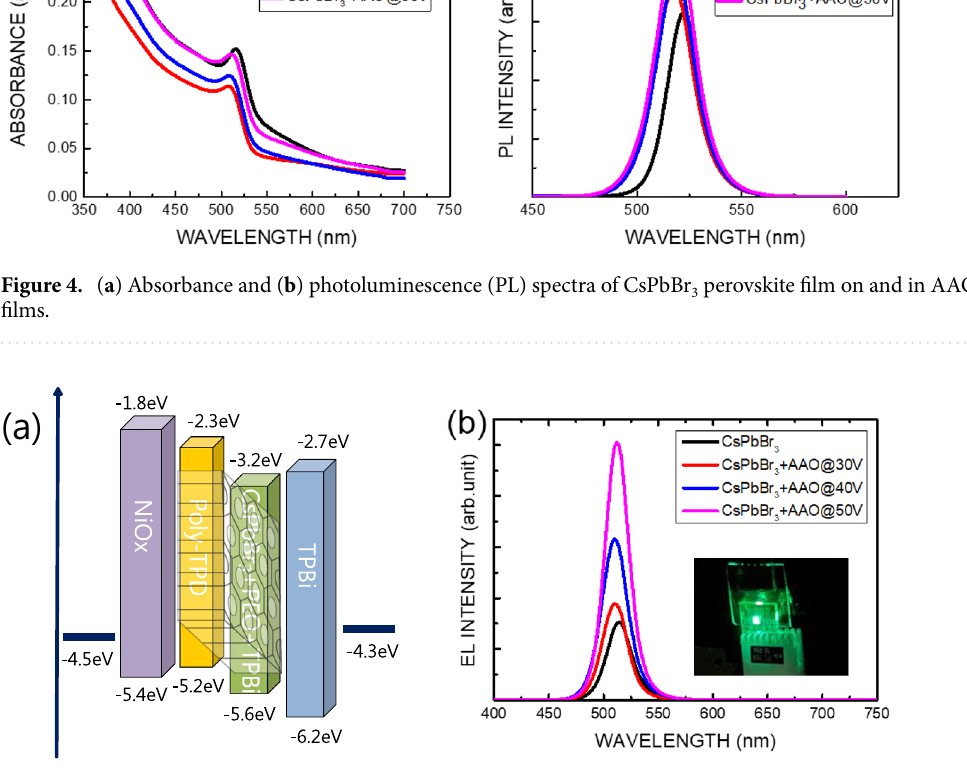
Figure 5. ( a ) Diagram of the electron level of a CsPbBr 3 PeLED with AAO. ( b ) Electroluminescence (EL) spectra of the CsPbBr 3 PeLEDs with and without AAO structures for various pore-expanding voltages. The inset of ( b ) is a photo of the CsPbBr 3 PeLED with an AAO structure and a pore-expanding voltage of 50